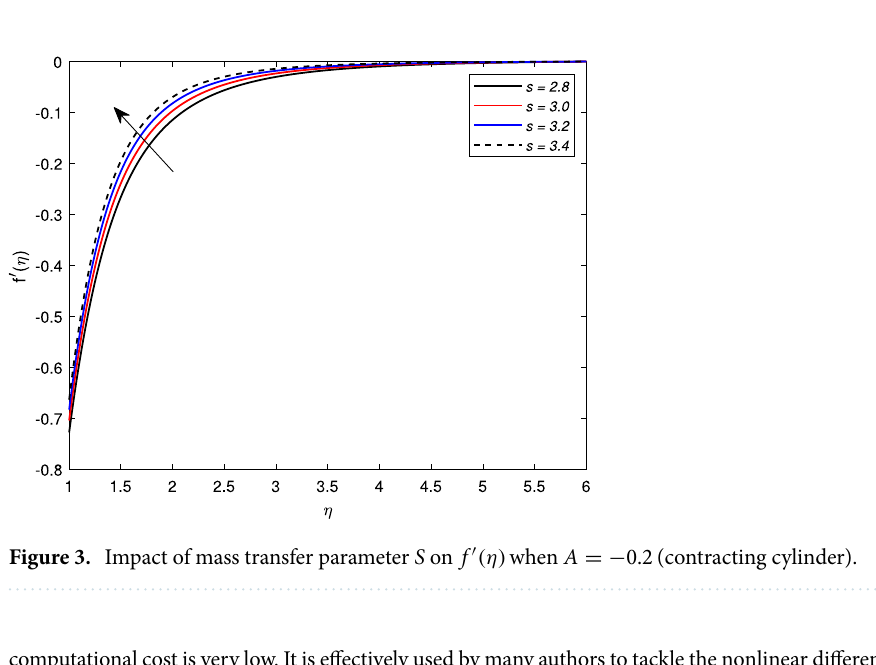
0.2 (contracting cylinder). = −